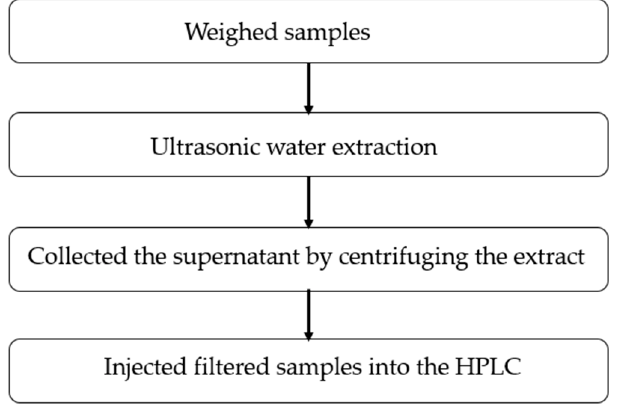
Figure 1. Information block diagram of UAE.